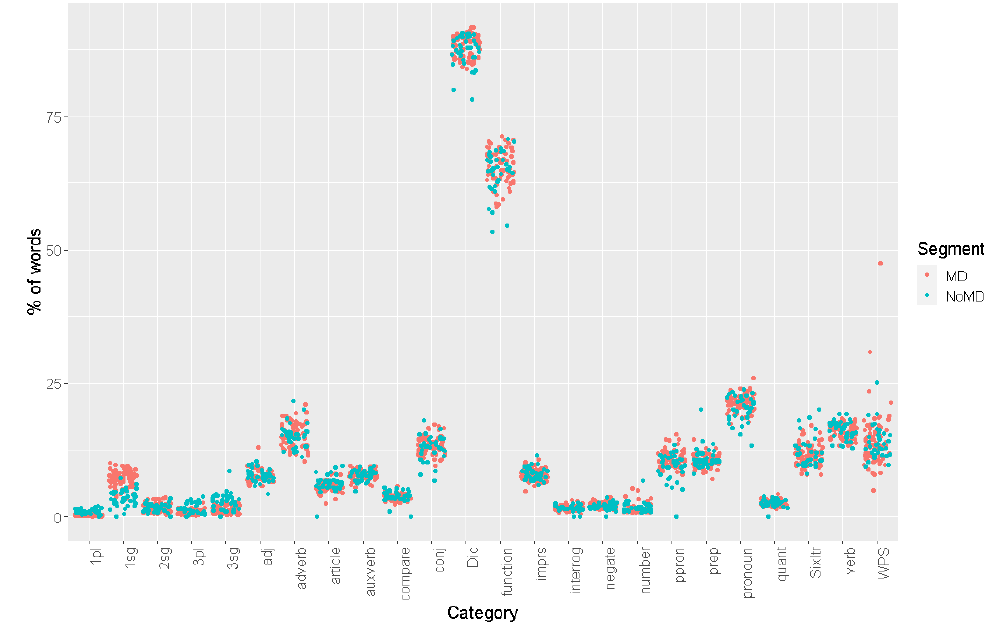
Figure 4. This stripchart plot illustrates the potential to identify people with and without a mental disorders based on the empirical frequencies of hypothesised LIWC category occurrences, e.g., first-person singular pronoun